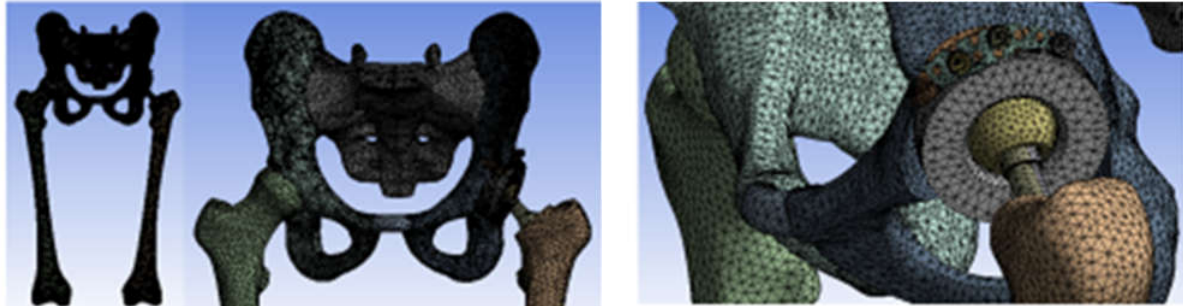
Figure 45. The finite element structure of the analysed orthopaedic system. In the static structural module, the same loading scheme was used based on the force ranging from 800 to 2300 N positioned on the sacrum bone and the same fixation scheme on the femoral condyles. The required materials were defined or loaded in the engineering data module. These are listed in Table 3 [45–57]. Table 3. Physico-mechanical characteristics of the materials used in the simulation for the system with morcellated bone graft.